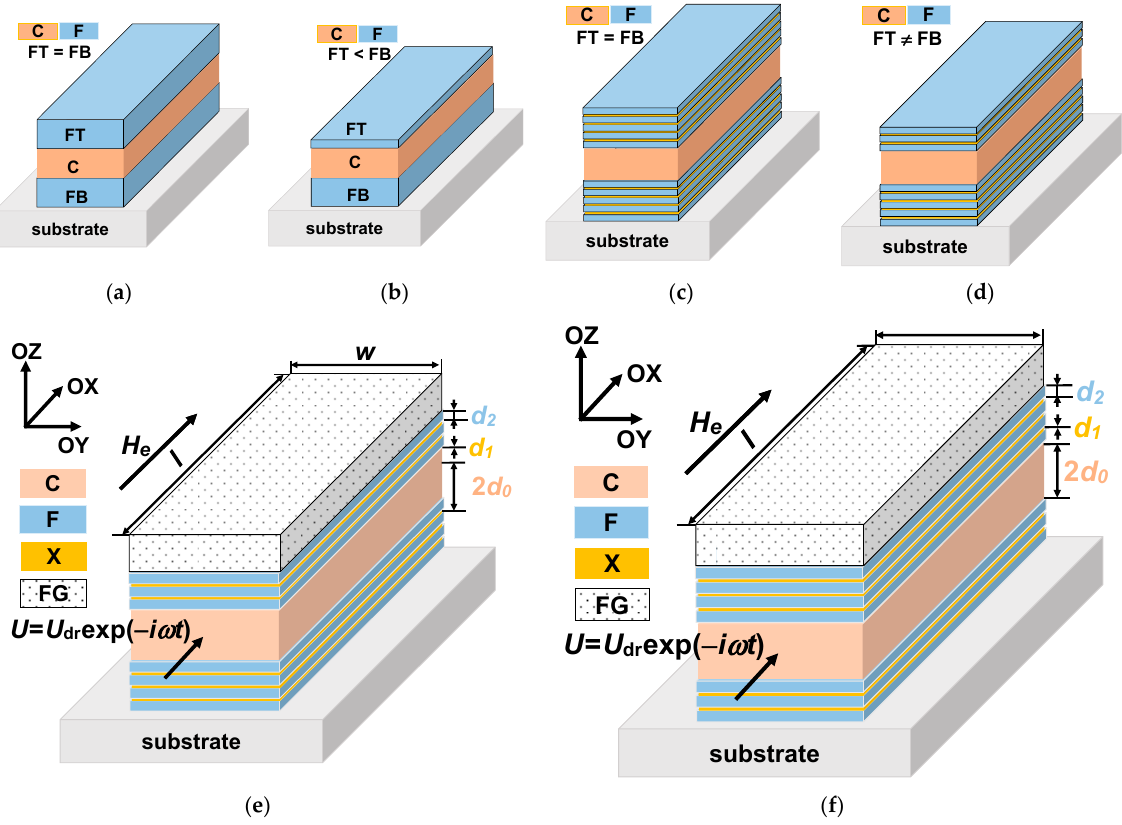
Figure 1. Schematic representation of the MI multilayered structures. Symmetric structures of “sandwich” type with equal thicknesses of ferromagnetic and conductive layers ( a ). Non-symmetric structure of “sandwich” type with different thicknesses of ferromagnetic top and bottom layers ( b ). Symmetric MI structure with equal thicknesses of top and bottom identical multilayers consisting of ferromagnetic soft magnetic sub-layers separated by non-ferromagnetic spacers and conductive central layer ( c ). Non-symmetric MI structures with different thicknesses of top and bottom multilayers consisting of ferromagnetic soft magnetic sub-layers separated by non-ferromagnetic spacers and conductive central layer ( d ). Studied non-symmetric multilayered films: the multilayer with ferrogel placed onto the surface of thin layer ( e ) and onto the surface of thick layer ( f ).